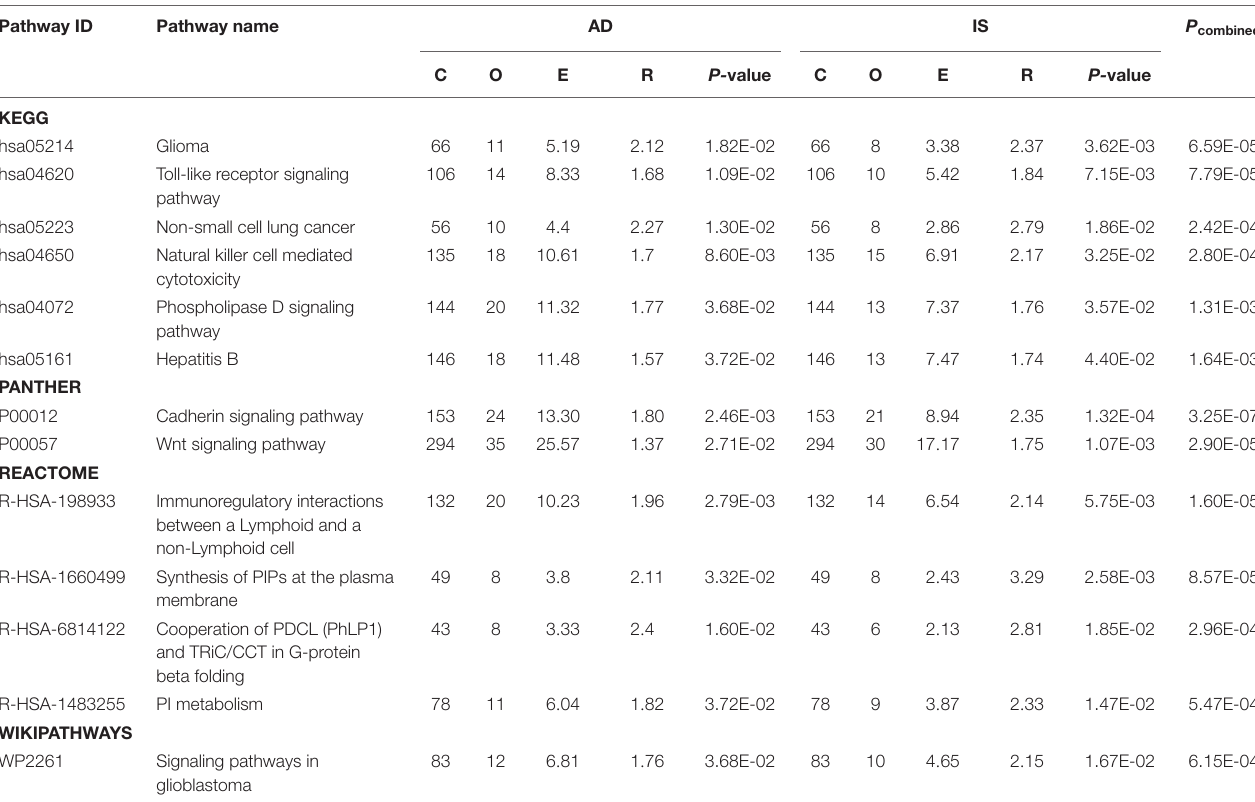
TABLE 1 | Shared biological pathways between AD and